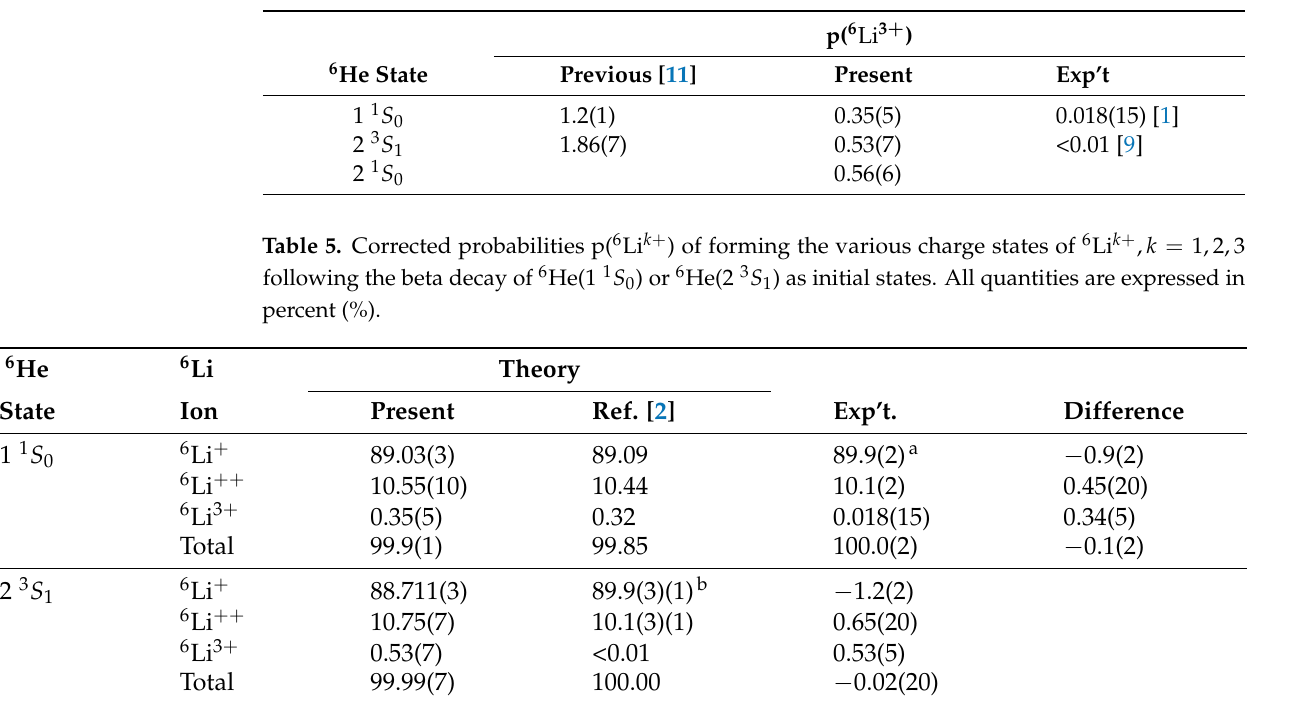
Table 4. Previous [11] and corrected 6 Li 3 + charge-state fractions for each initial state following beta decay. All quantities expressed in percent (%).